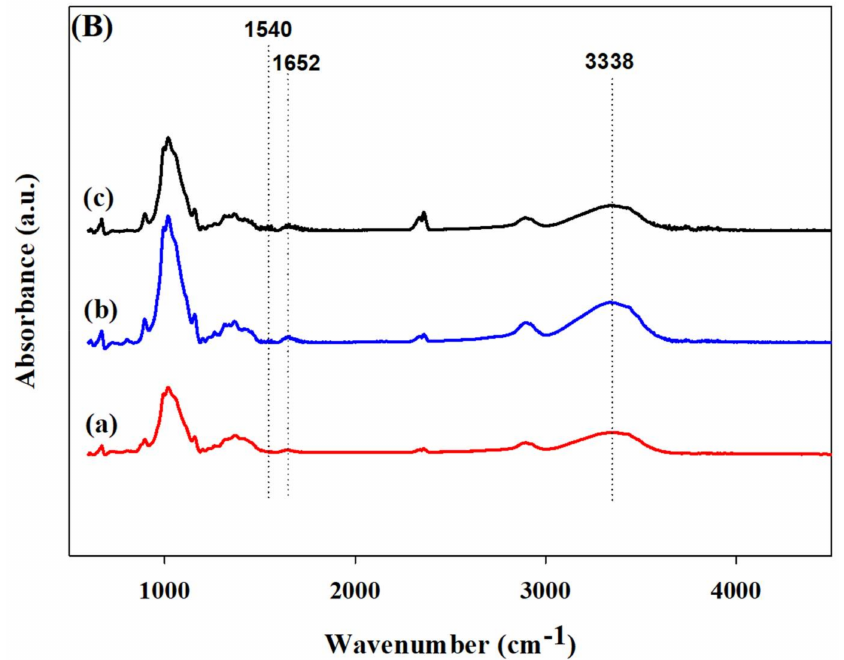
Figure 5. FTIR analysis of the composites and raw materials ( A ): ( a ) RC, ( b ) Chlamydomonas angulosa , ( c ) RCCA-5, ( d ) Nostoc commune , and ( e ) RCNC-5. Furthermore, cadmium-adsorbed of composites ( B ): ( a ) RC, ( b ) RCCA-5 and ( c )